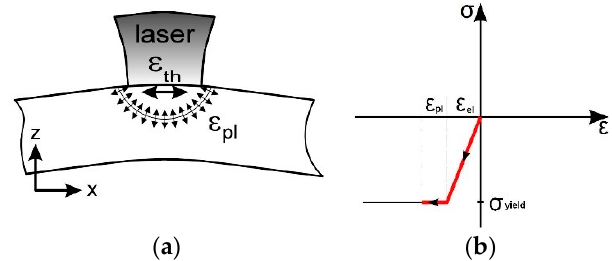
Figure 4. ( a ) Temperature gradient mechanism during laser heating, ( b ) representation of the evolution of thermal stress and strains in the irradiated zone [43].